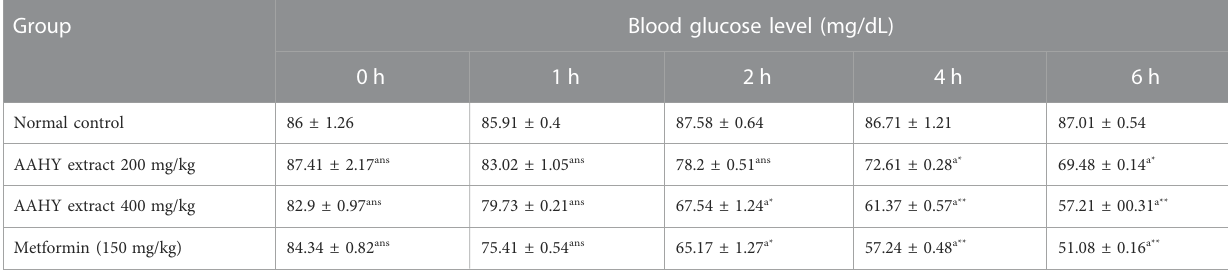
The values are represented as mean ± SEM, and n = 6 for each group. a All treated groups versus the normal control group at the corresponding time period. ns No signi fi cant difference. ans No signi fi cant difference observed when all treated groups were compared to the normal control group at the corresponding time point. SEM, standard error of mean; AAHY extract,